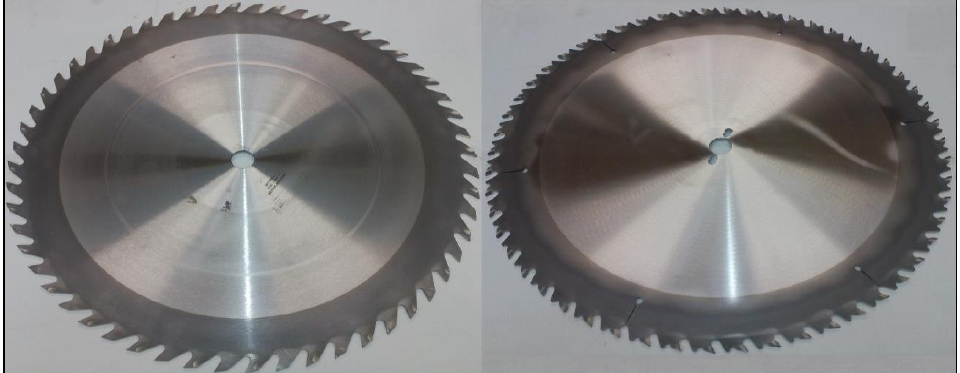
Figure 2. Saw blades with CRONAL I coating (HSS_C_I, SK_C_I) .